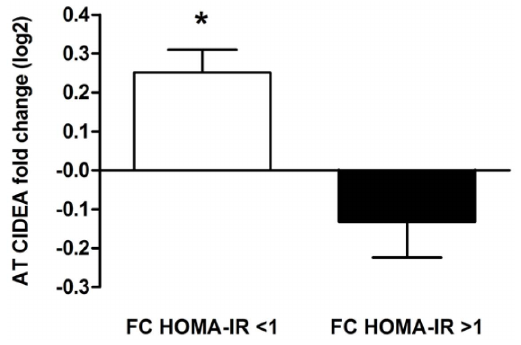
Figure 3. Human adipose tissue CIDEA gene expression according to insulin resistance profiles (n=216). Relative CIDEA mRNA levels in subcutaneous adipose tissue were plotted according to groups compared to baseline, after 8 weeks low calorie diet (LCD, white bars), and after 6 months of weight maintenance diet (WMD, black bars). AT, adipose tissue; HOMA-IR, Homeostasis Model Assessment of Insulin Resistance. *: p , 0.05, difference between baseline and the end of LCD or WMD. Values are means 6 SEM. PLOS ONE |